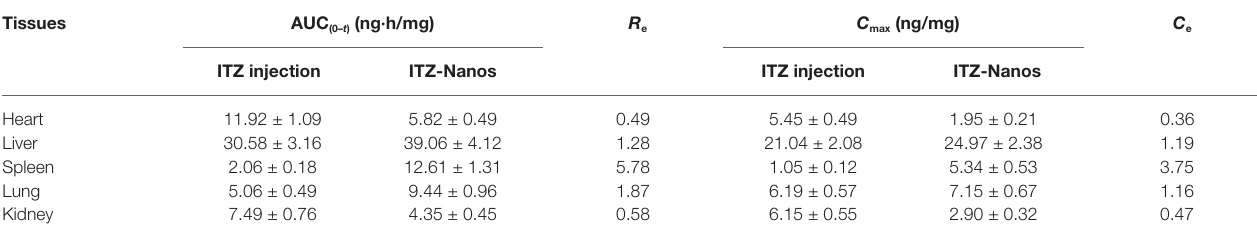
TABLE 3 | The AUC (0– t ) and C max in different tissues of mice ( n = 5). Tissues